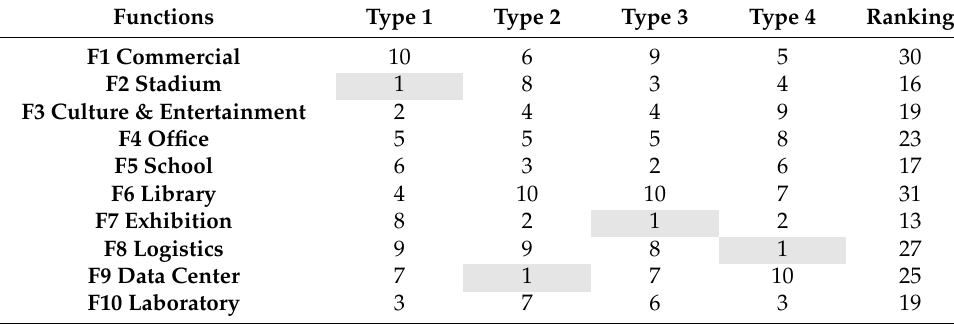
Table 4. Function replacement rankings for each UPS type.